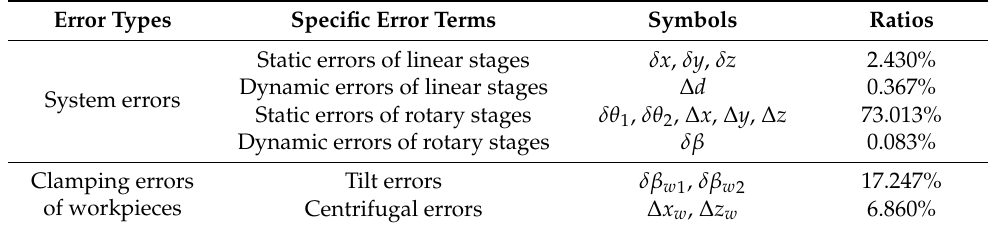
Table 1. The error classification of the five-axis measurement system.